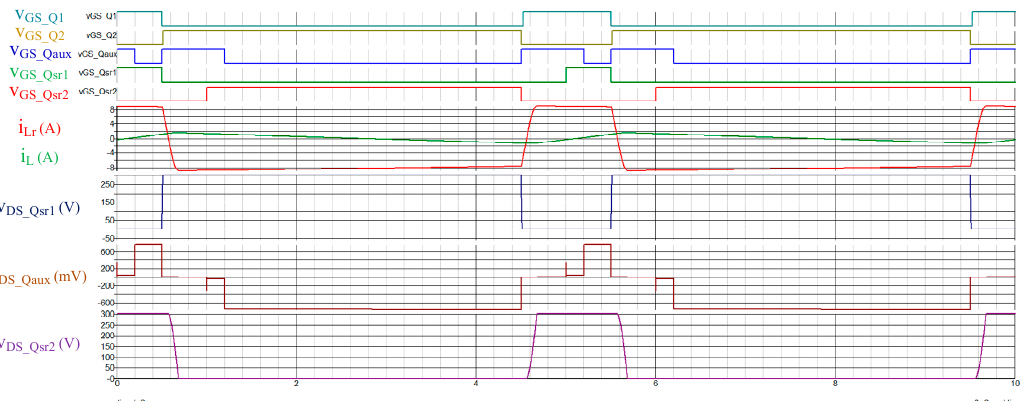
Figure 14. Simulation results: v GS and v DS waveforms of each switch, resonant inductor and output inductor current waveform at V O = 50 V, Io = 0